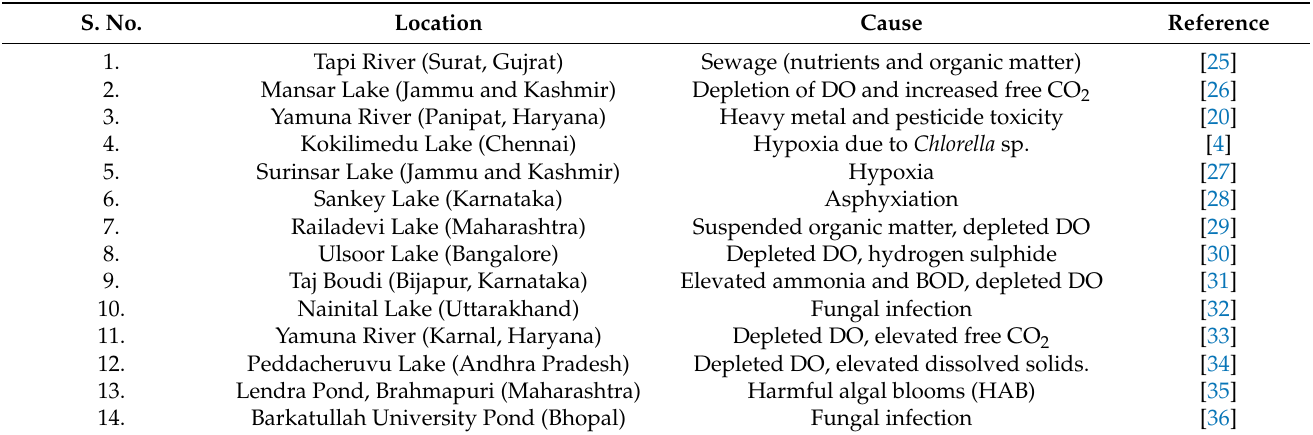
Table 1. Details of recent fishkill episodes in various aquatic ecosystems across India. S.